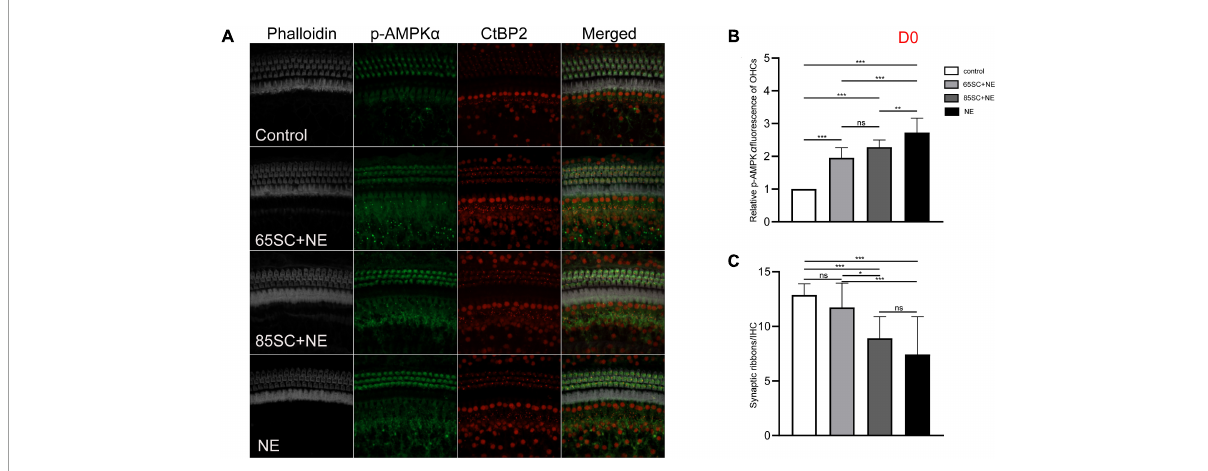
FIGURE5 The p-AMPK α fluorescence intensity and the number of ribbon synapses changed in each group of mice after being exposed to 110 dB SPL noise at D0. (A) The p-AMPK α fluorescence intensity and the number of synapses of the four groups at D0. (B) NE group showed the highest p-AMPK α fluorescence intensity ( p < 0.001), and the intensity of SC+NE groups were stronger than the control group ( p < 0.001). (C) The number of synapses did not differ between the 65SC+NE group and the control group ( p > 0.05), and both the 85SC+NE group and the NE group showed less synapses than the control group and 65 SC group. * p < 0.05, ** p < 0.01, *** p <